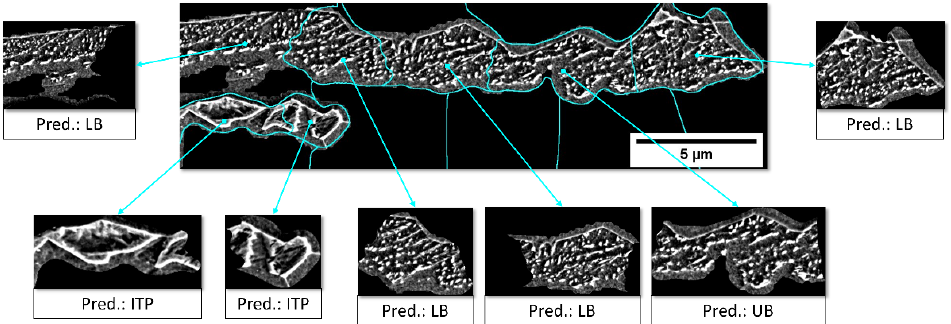
Figure 5. Big second phase object that was flagged as an insecure prediction after probabilistic classification because it contains structures from several classes. By automatically tiling the image into sub-images, a more accurate and sophisticated classification is achieved.